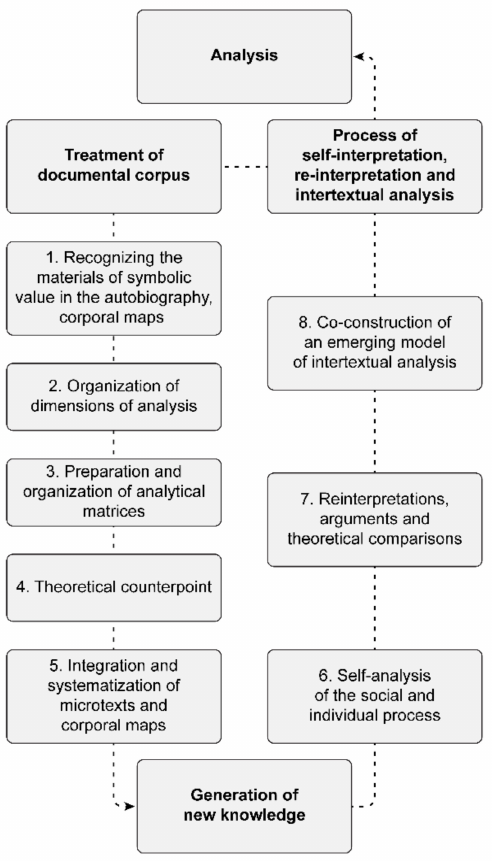
Figure 5. Example of interpretation of the documental corpus. Source: